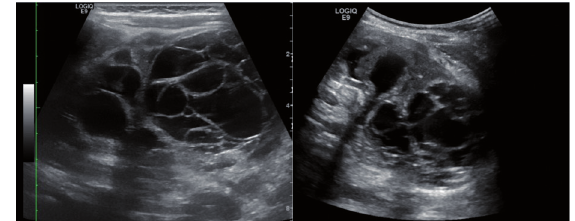
Figure 2. Renal US of a 5-month-old male (same patient of Figure 1). The images show the presence of bilateral CN that appears as multiloculated cystic lesions, with margins well circumscribed by the surrounding renal parenchyma and internal septa. Caliectasies are also present. Image